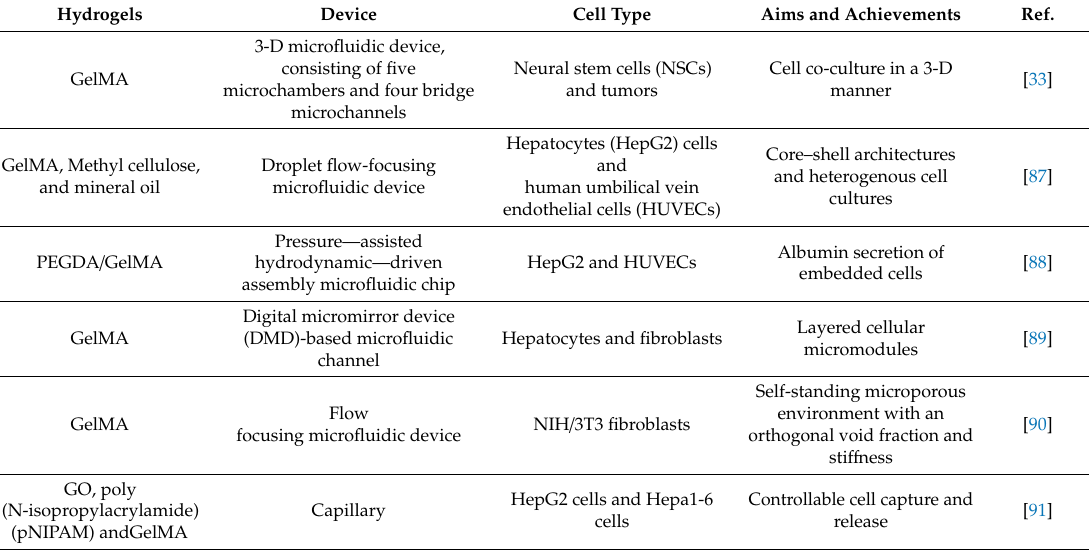
Table 1. Summary of the roles of GelMA hydrogels in cell co-culture microfluidic facility.